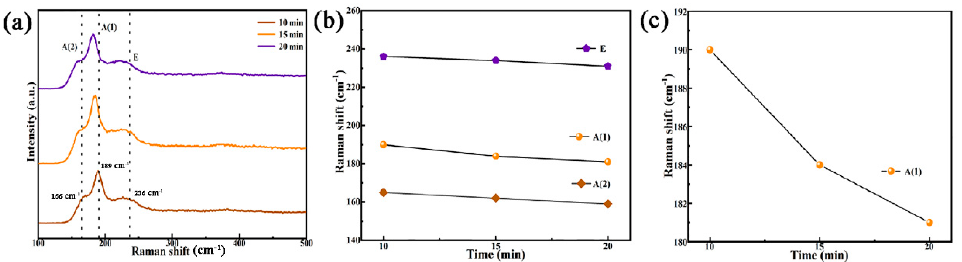
Figure 5. ( a ) Raman spectra of CNZTSSe films obtained at various selenization times; ( b ) Variation curve of various vibration mode peaks with selenization time; ( c ) Variation curve of main Raman vibration mode A (1) with selenization time. Figure 6 indicates the XPS spectra of all elements in the CNZTSSe films at the opti ‐ mum selenidation time (15 min). Figure 6a displays the XPS spectrum of Cu 2p core en ‐ ergy level. The Cu 2p 3/2 and Cu 2p 1/2 peaks were obtained at 931.5 and 951.4 eV, and the peak position difference was 19.9 eV. This difference value is consistent with the bind ‐ ing energy of Cu 2+ , indicating that the Cu is + 2 valence in the film [33]. Figure 6b displays the XPS spectrum of Sn 3d core energy level. The two peaks of Sn 3d are located at 486.4 eV and 494.8 eV, with a binding energy difference of 8.4 eV. Therefore, the above two peaks are tetravalent Sn 3d 5/2 and Sn 3d 3/2 (Sn +4 ), separately [34]. Figure 6c displays the peaks of Zn 2p 3/2 and Zn 2p 1/2 at 1021.7 eV and 1044.8 eV. The peak level difference is 23.1 eV, which conforms to the binding energy of Zn 2+ , indicating that Zn exists at + 2 valence in the film [35]. The XPS spectrum of S 2p (Figure 6d) indicates the four peaks of S 2p 3/2, S 2p 1/2, Se 3p 3/2, and Se 3p 1/2, located at 160.3 eV, 161.2 eV, 159.7eV and 166.0eV, separately . The two peaks at 160.3 eV and 161.2 eV have a binding energy differ ‐ ence of 0.9 eV [36]. This agrees with the 160–164 eV range of S 2 − , revealing that the valence state of S is + 2 [36]. The Se 3d 3/2 and Se 3d 1/2 peaks are respectively located at 54.04 and 54.7 in Figure 6e. The split value is consistent with the binding energy value of Se 2 − [37]. In Figure 6f, Ni 2p 3/2 and Ni 2p 1/2 core levels with a peak separation of 17.5 eV were observed at 852.9 and 870.4 eV, respectively, indicating that Ni atoms with a valence state of + 2 have been successfully doped into CZTSSe films [38]. In addition, there are two satellite vibration peaks in the XPS spectrum of the Ni 2p core level, which does not affect the results of Ni valence analysis [39]. XPS test displays that the constituent elements CNZTSSe film exist in the forms of Cu + , Zn 2+ , Sn 4+ , S 2 − , Se 2 − , and Ni 2+ .